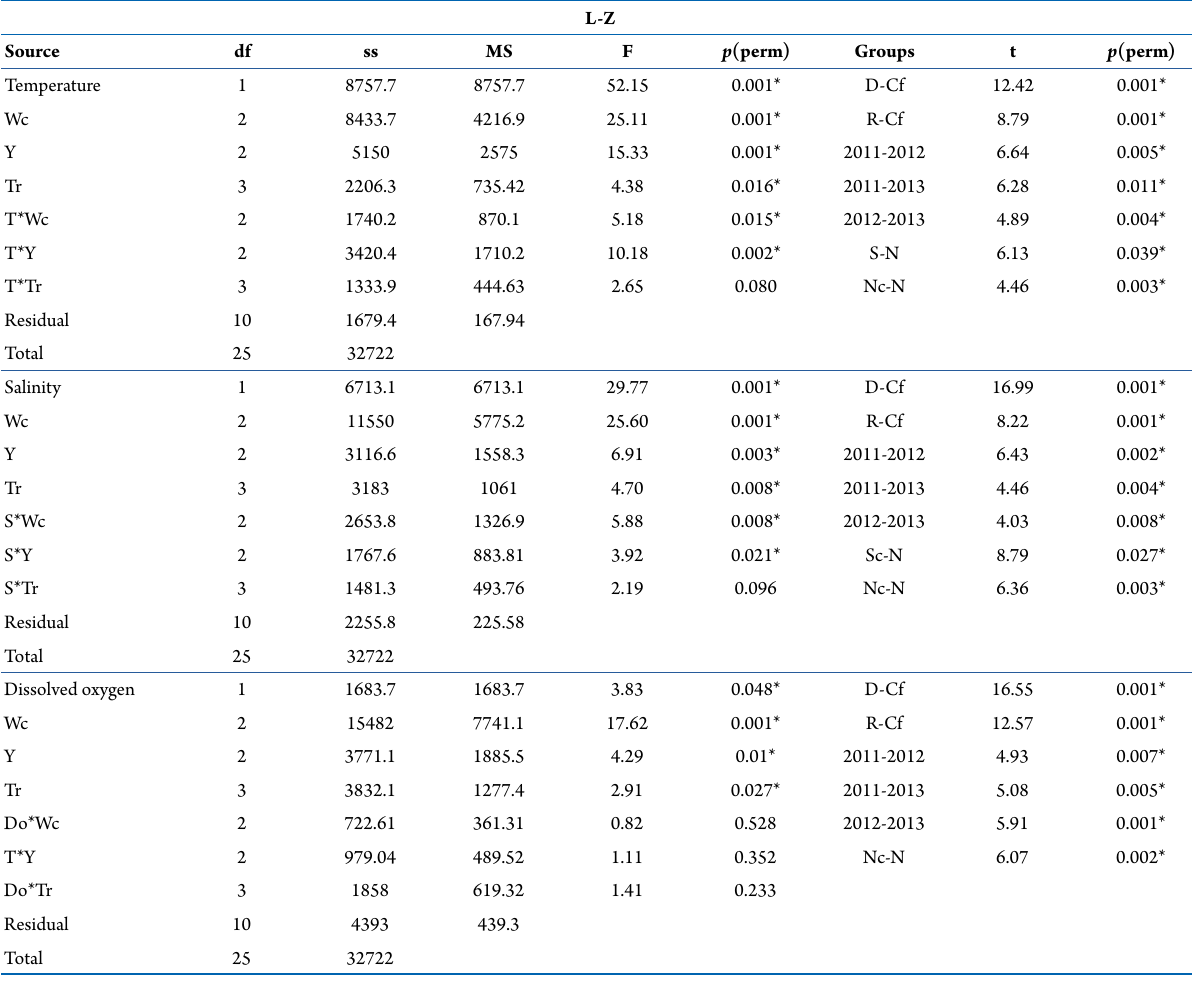
Table 6. Permutational multivariate analysis of variance on the density of the Brachyura zoea I community, based on an orthogonal three-factors model, with environmental parameters as covariates. Pairwise tests between weather conditions (Wc), Years (Y) and Zones (Z) from the standard model of the PERMANOVA. Cold fronts, Cf; Dry, Dr; Transect, Tr; Northern, N; North central, Nc; Rainy, Ra; Southern, S; South central, Sc. *, significant differences p < 0.05.